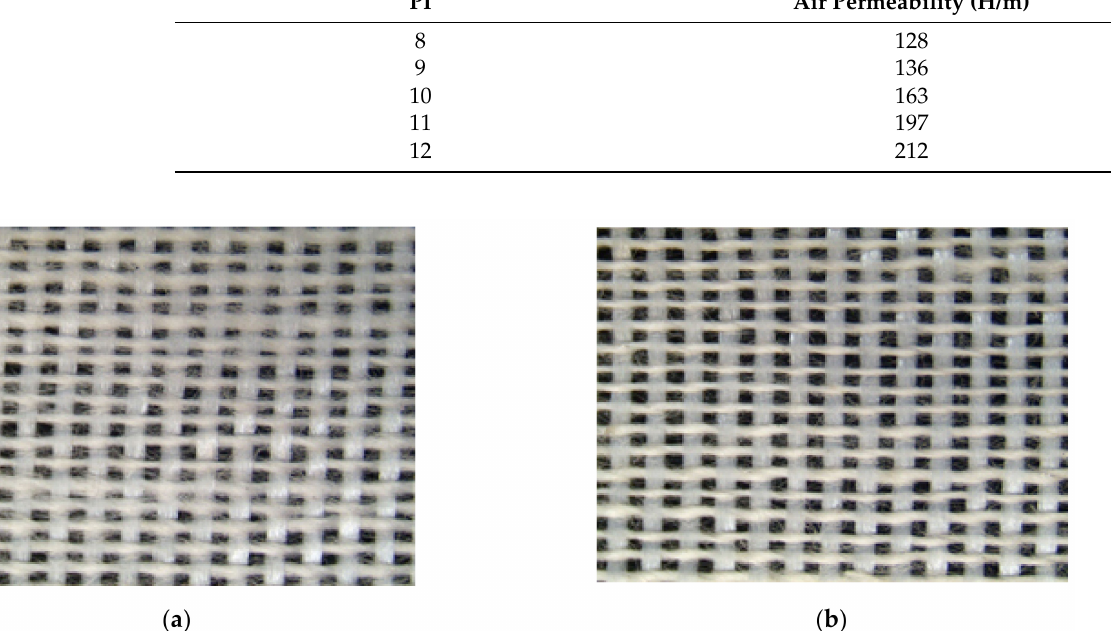
Figure 10. Surface image of non-woven fabrics composed of Ge/SS core-spun yarns with a TPI of ( a ) 8 and ( b )